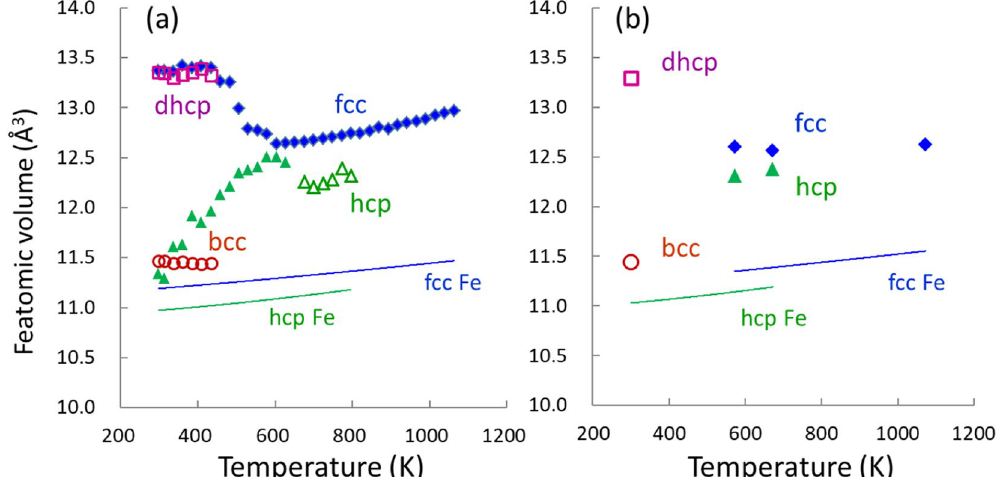
Figure 4. ( a ) The v Fe – T relations of fcc (blue solid diamonds), dhcp (purple open squares), and hcp (green solid triangles) hydrides and bcc Fe (brown open circles) obtained by X-ray diffraction, where the estimated atomic volumes for the precipitated hcp hydride are represented by green open triangles; ( b ) estimated atomic volumes determined by neutron diffraction, where the symbols have the same meaning as in the left panel; in both ( a , b ) panels, the calculated v Fe – T relations for hcp Fe and fcc Fe are represented by green and blue lines, respectively.